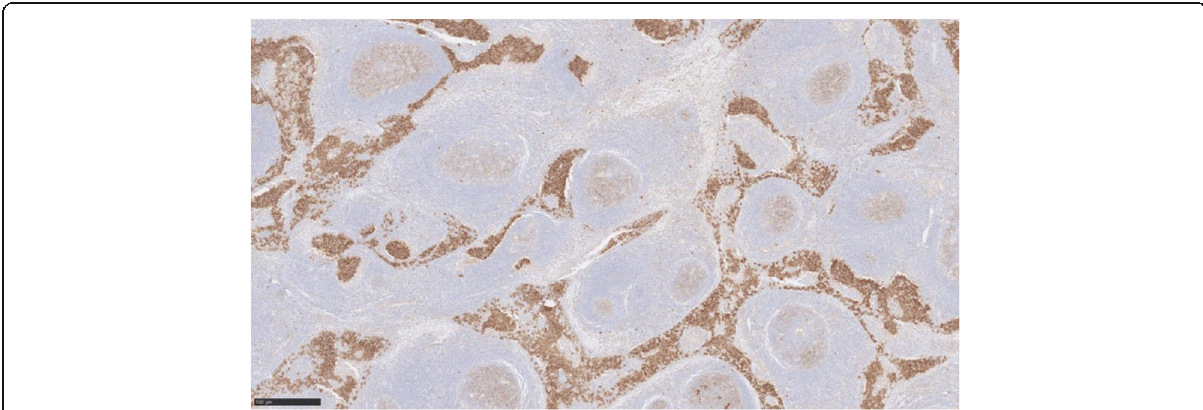
Fig. 4 Immunohistochemistry CD117, image × 5 magnification, confirming the diagnosis of seminoma